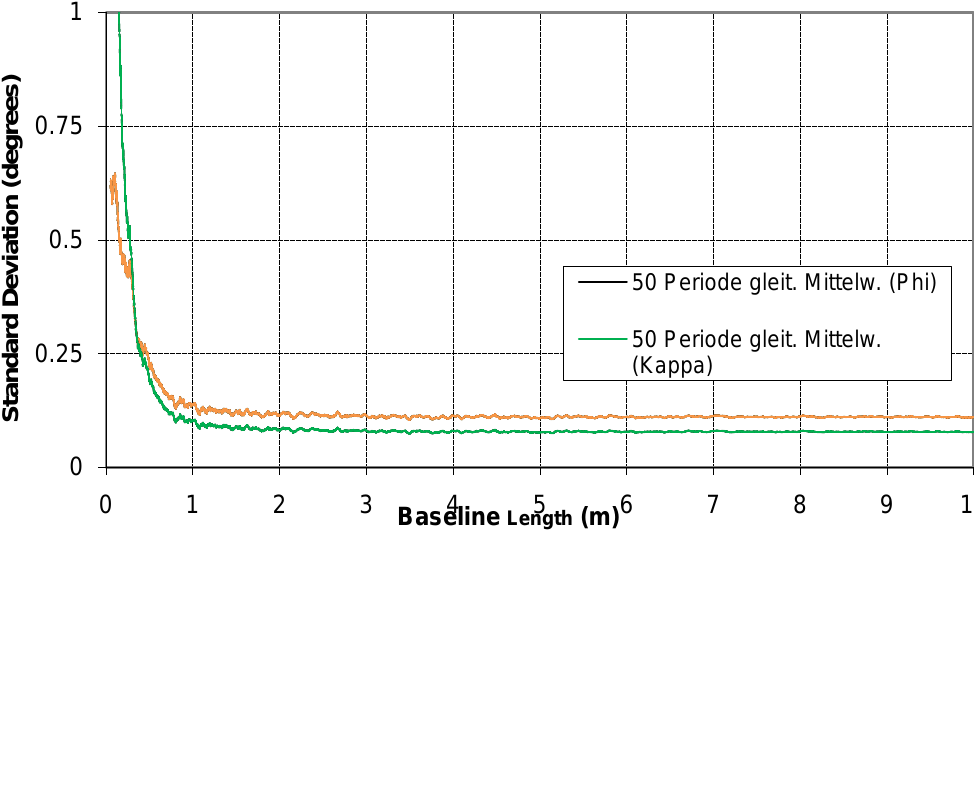
Figure 7. Simulation Results of the Dual-Antenna Case showing precision of calculated orientation angles vs. mounting bar length for systematic two device stops; the curve's actual dampening happens at about 1 m bar length which show the practicality of the method; it can also be noticed that the achieved accuracy at the 1 m bar length value is close to what is required for stationary LiDAR but not enough with two device